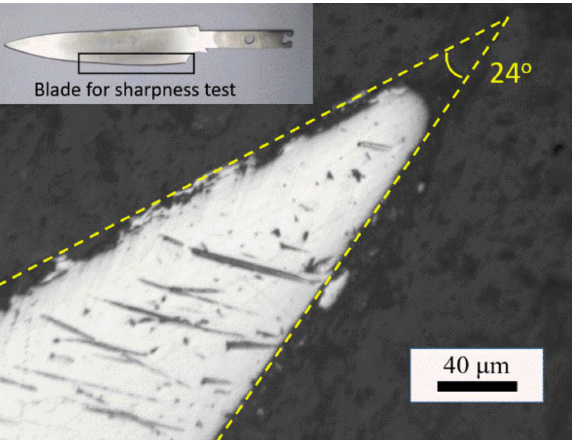
Figure 2. The blade edge for sharpness test on a sample of steel knife (inset) and the round tip geometry with the blade angle 24 ◦ after the sharpness